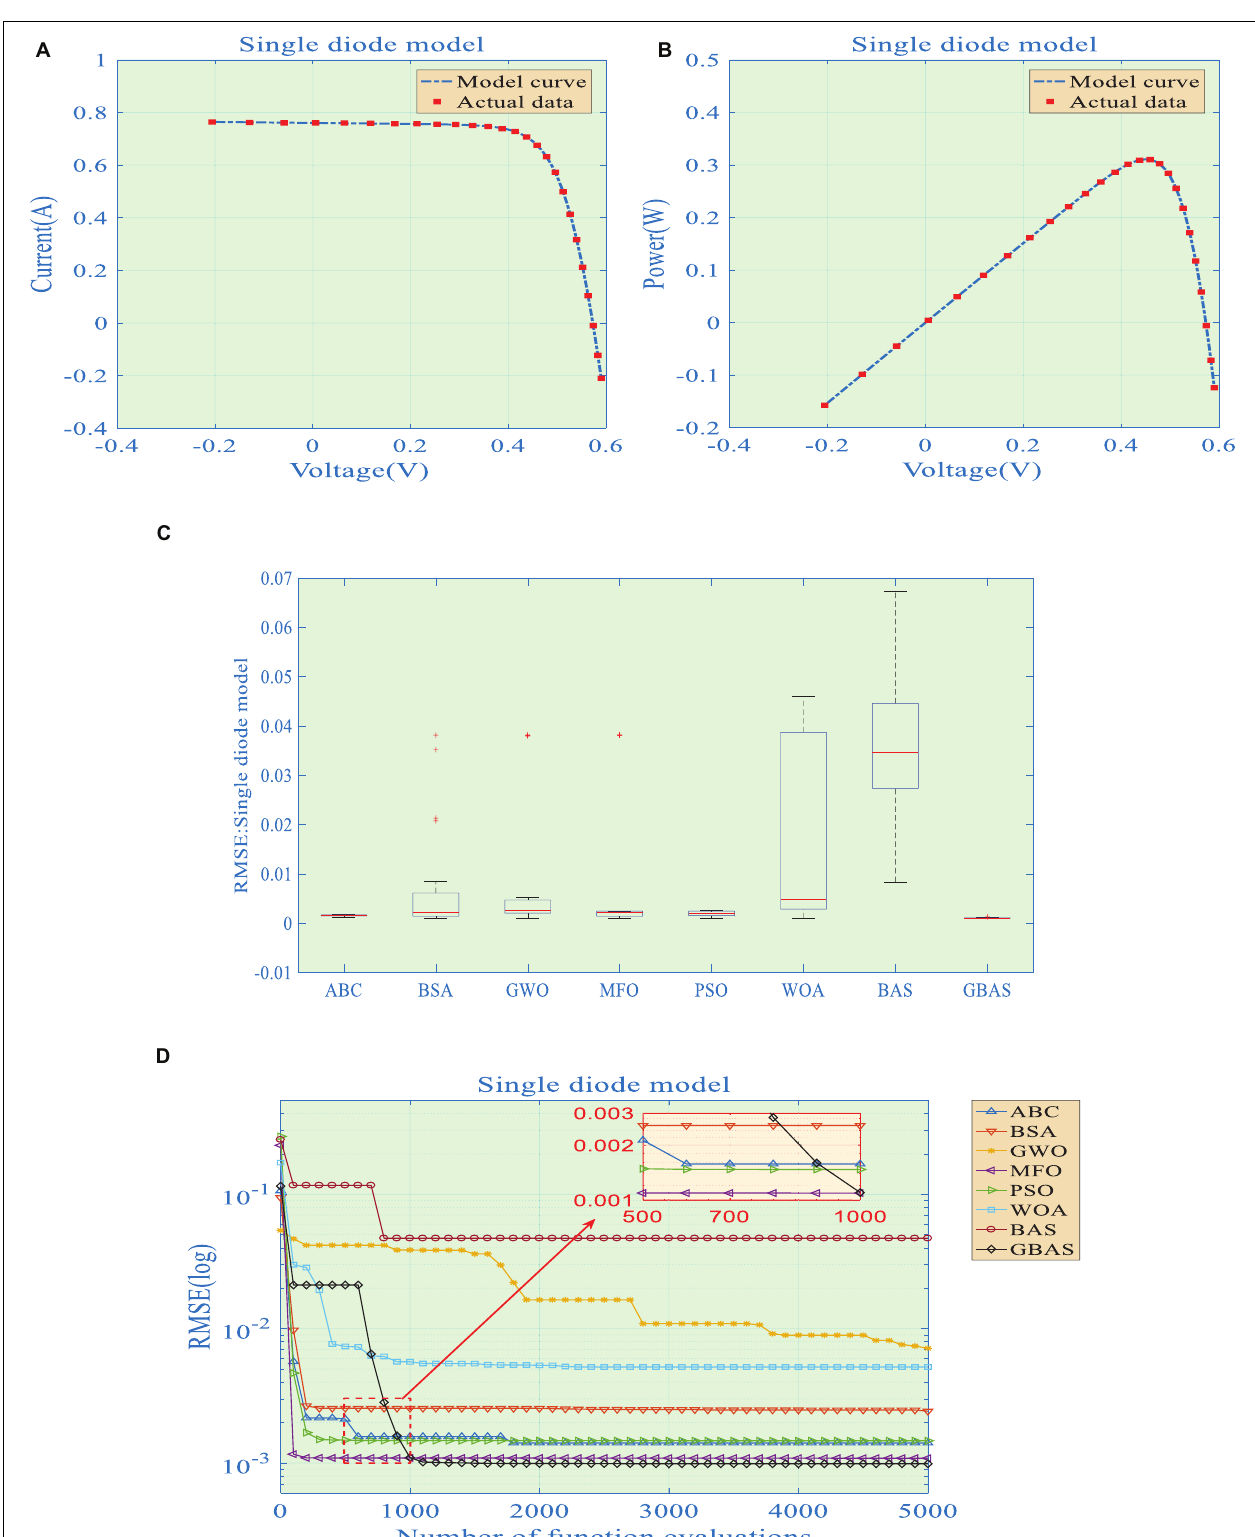
Frontiers in Energy Research |